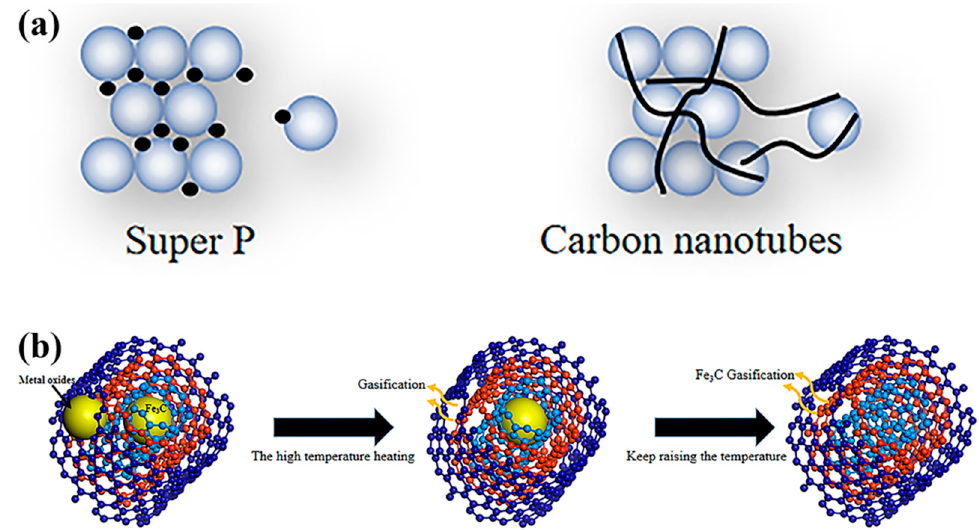
Figure 8. ( a ) Schematic diagram of Super P, CNTs and positive particles connection; ( b ) Schematic diagram of the mechanism of high-temperature purification of carbon nanotubes.